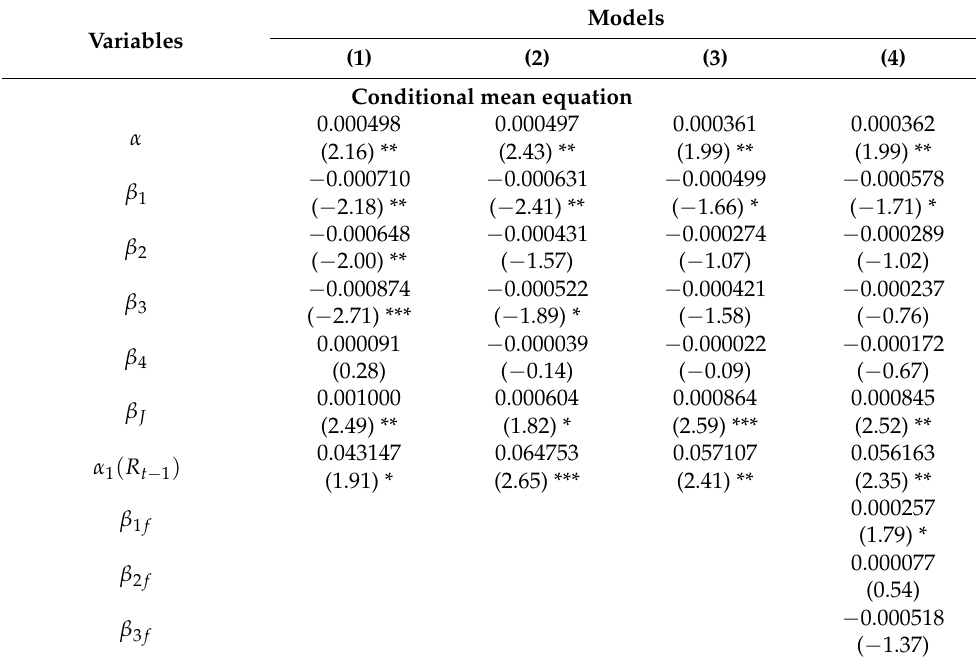
Table 5. Empirical findings for the entire